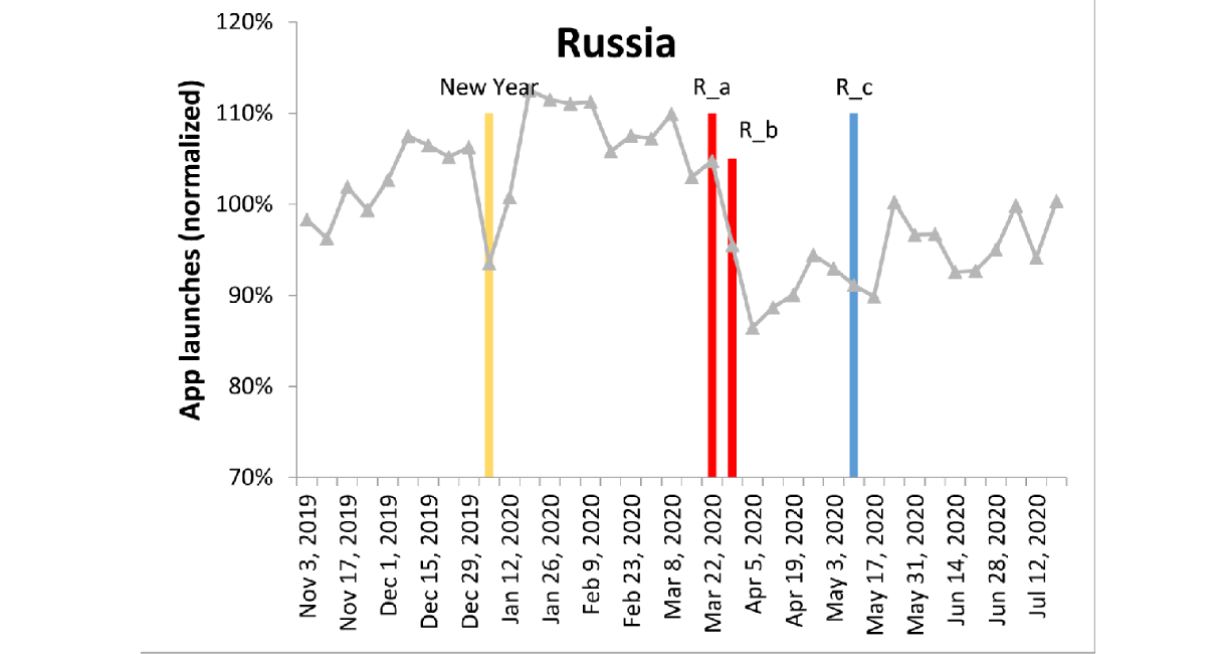
Figure 3. App launch fluctuations in Russia, normalized by the average number of weekly app uses. Yellow: holiday, red: lockdown, and blue: postlockdown. In Russia, Eastern Orthodox Christmas was on January 7. R_a: Ministry of Culture announced the closure of all cultural institutions under its jurisdiction; Minister of Education Sergey Kravtsov announced the closure of all Russian schools from March 23, 2020. R_b: Moscow issued a stay-at-home order for all residents. R_c: President Vladimir Putin announced an end to Russia’s 6-week nationwide lockdown despite a record increase in COVID-19 cases.